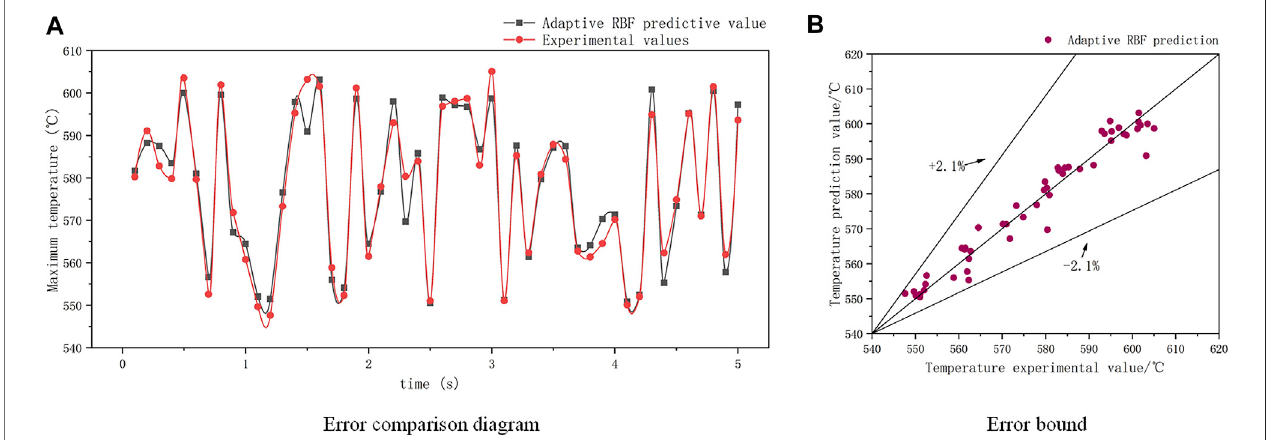
FIGURE 9 | The error comparison diagram and the error bound of adaptive RBF neural network under coolant mass fl ow variation condition.